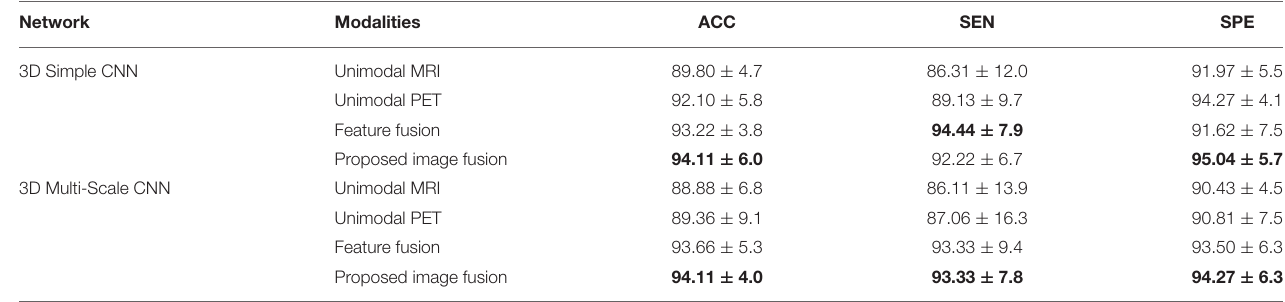
TABLE 2 | Results of different modalities with different networks for AD vs. NC (UNIT:%).